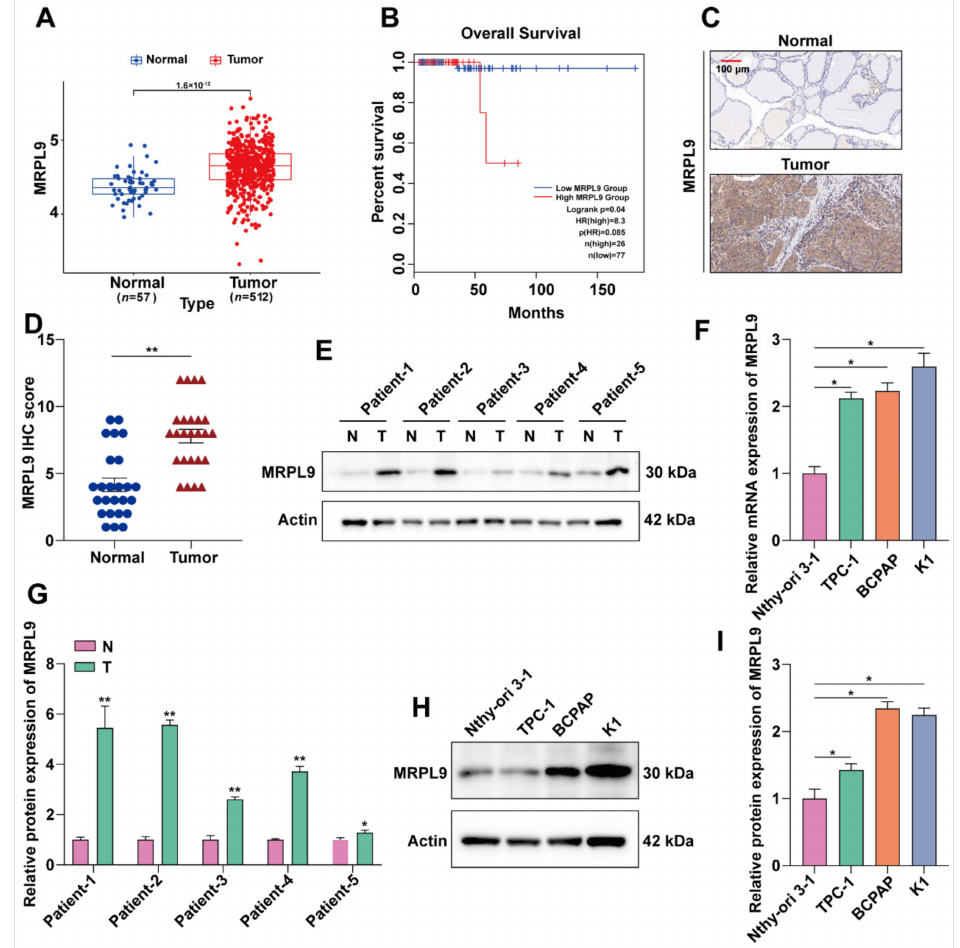
Figure 1. MRPL9 is highly expressed in PTC. ( A ) The expression level of MRPL9 in thyroid cancer was analyzed by TCGA database. ( B ) The GEPIA2 website (http://gepia2.cancer-pku.cn/#index, accessed on 22 March 2022) analyzed the effect of MRPL9 on the survival and prognosis of patients with thyroid cancer. ( C ) Representative images of MRPL9 immunohistochemistry (IHC) of normal PTC tissue (top) and PTC tissue (bottom) (IHC score: 10, scar bar = 100 µ m). ( D ) MRPL9 immunohistochemical score statistics of PTC group ( n = 26) and normal group ( n = 26) (Each dot represents a patient’s normal thyroid tissue, and each triangle represents a patient’s PTC tissue). ( E ) Representative Western blot of MRPL9 protein in 26 pairs of PTC tissues and normal tissues. ( F ) Western blot results were quantified and normalized to Actin ( n = 3). ( G ) RT-qPCR analysis examined the expression level of MRPL9 in Nthy-ori 3.1, TPC-1, K1, BCPAP cell lines ( n = 3). ( H ) Western blot detection of MRPL9 protein expression levels in Nthy-ori 3.1, TPC-1, K1, and BCPAP cell lines. ( I ) Western blot results were quantified and normalized to Actin ( n = 3). Measurement data (mean ± standard deviation) between two groups were compared by paired t test, and multiple groups were compared by one-way analysis of variance (ANOVA) with Tukey’s post hoc test. “*” represents p ≤ 0.05, “**” represents p ≤